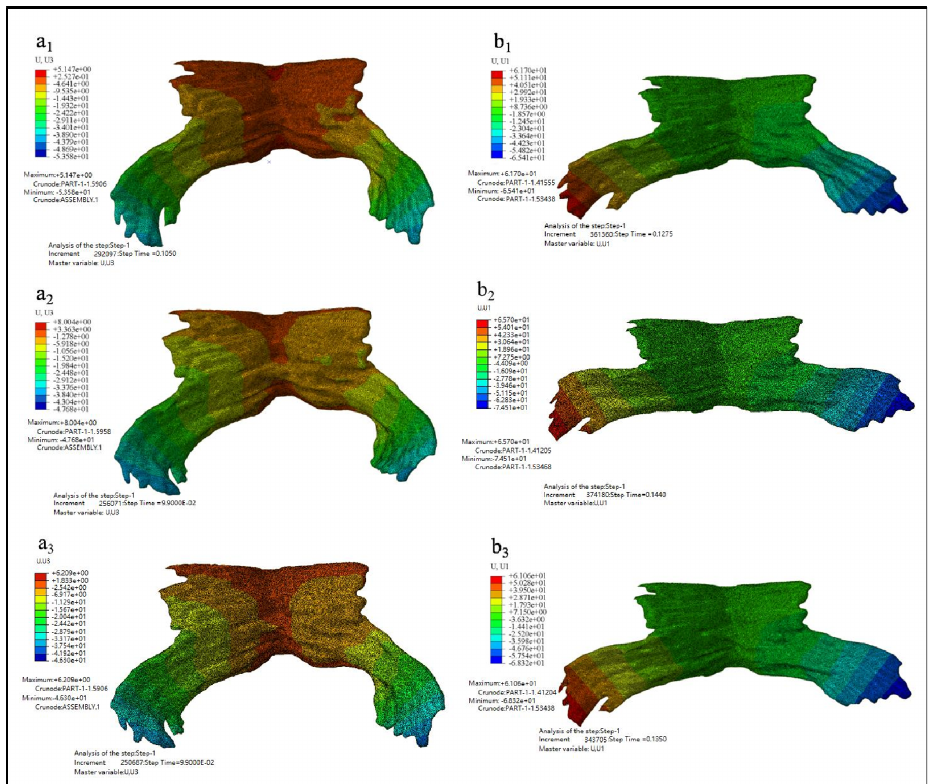
Figure 9. The displacement nephogram. (a1–a3 showed the displacement nephogram in the Z direction, u Z , of Model D80, D90 and D100 while b1–b3 showed the displacement nephogram in the X direction, u X , of Models D80, D90 and D100)